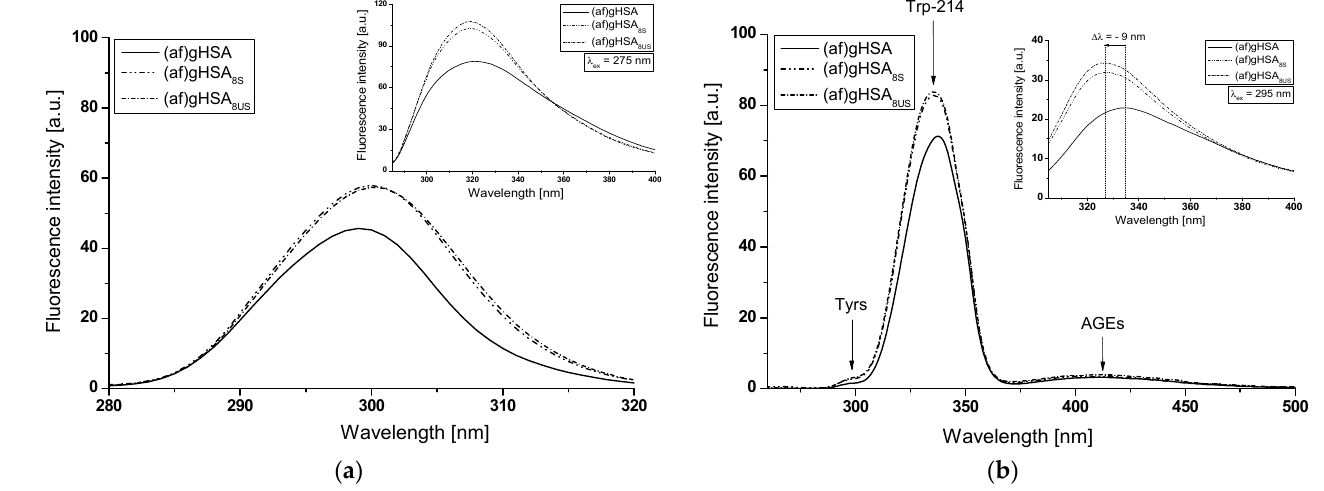
and Tyrs, respectively ( ∆ λ = λ em − λ ex ).